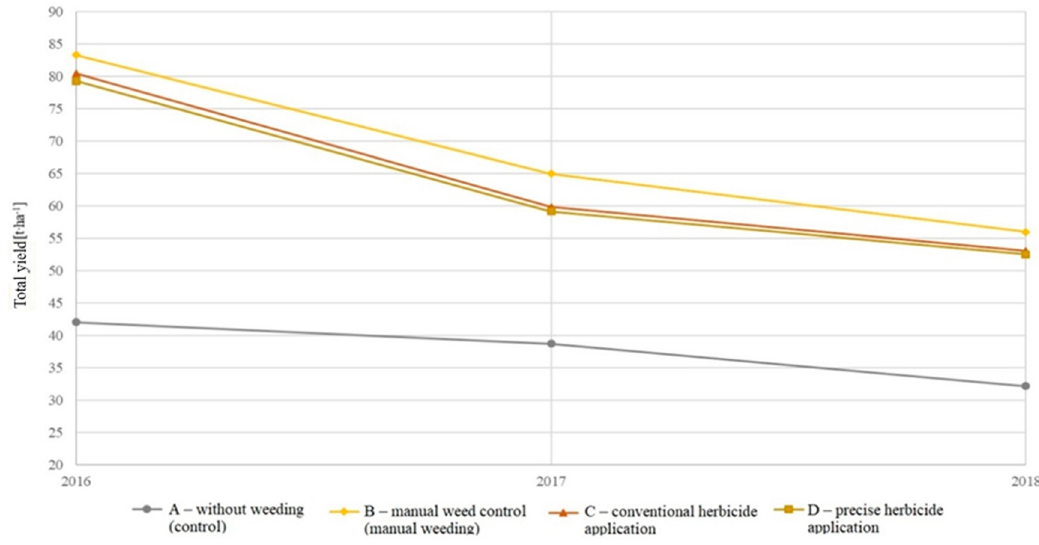
Figure 19. Reaction of total yield to changes in weather conditions depending on the weeding method (source: own work).